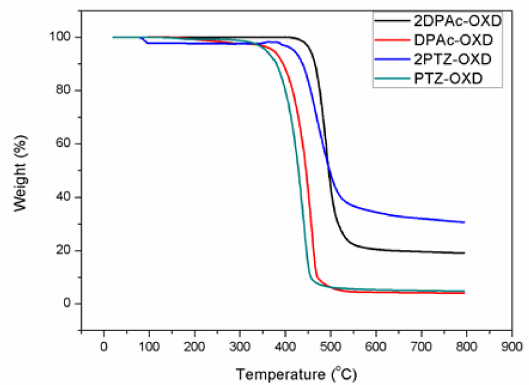
Figure 1. Thermal decomposition temperature (by thermogravimetric analysis, TGA) of fluorescent